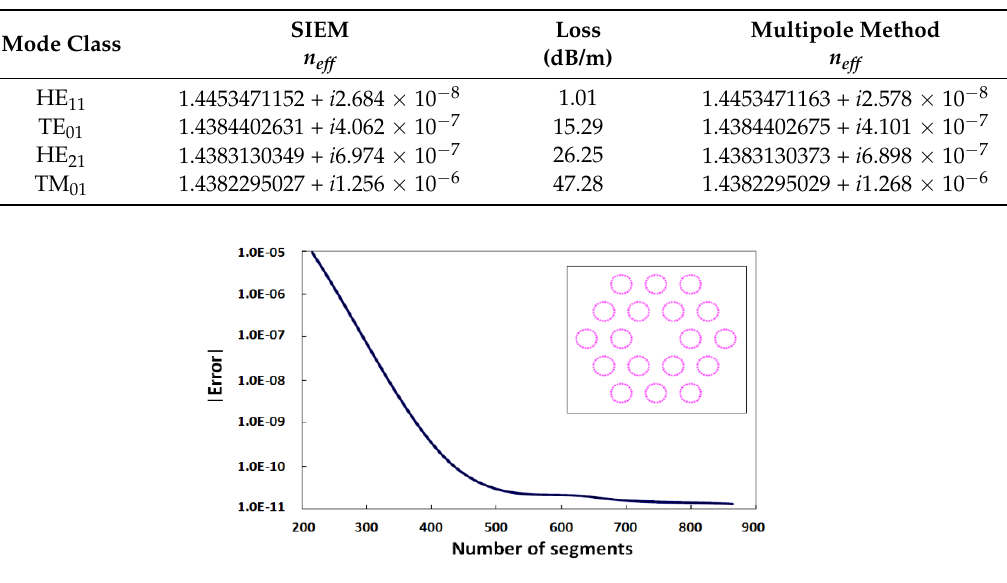
Figure 3. Dependence of the relative error on the number of segments for the 2 air-hole ring (18 air-holes) configuration.